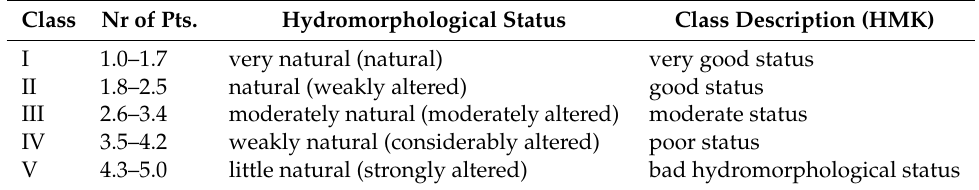
Table 4. Classification of the hydromorphological status according to HEM (agreement with WFD). Class Nr of